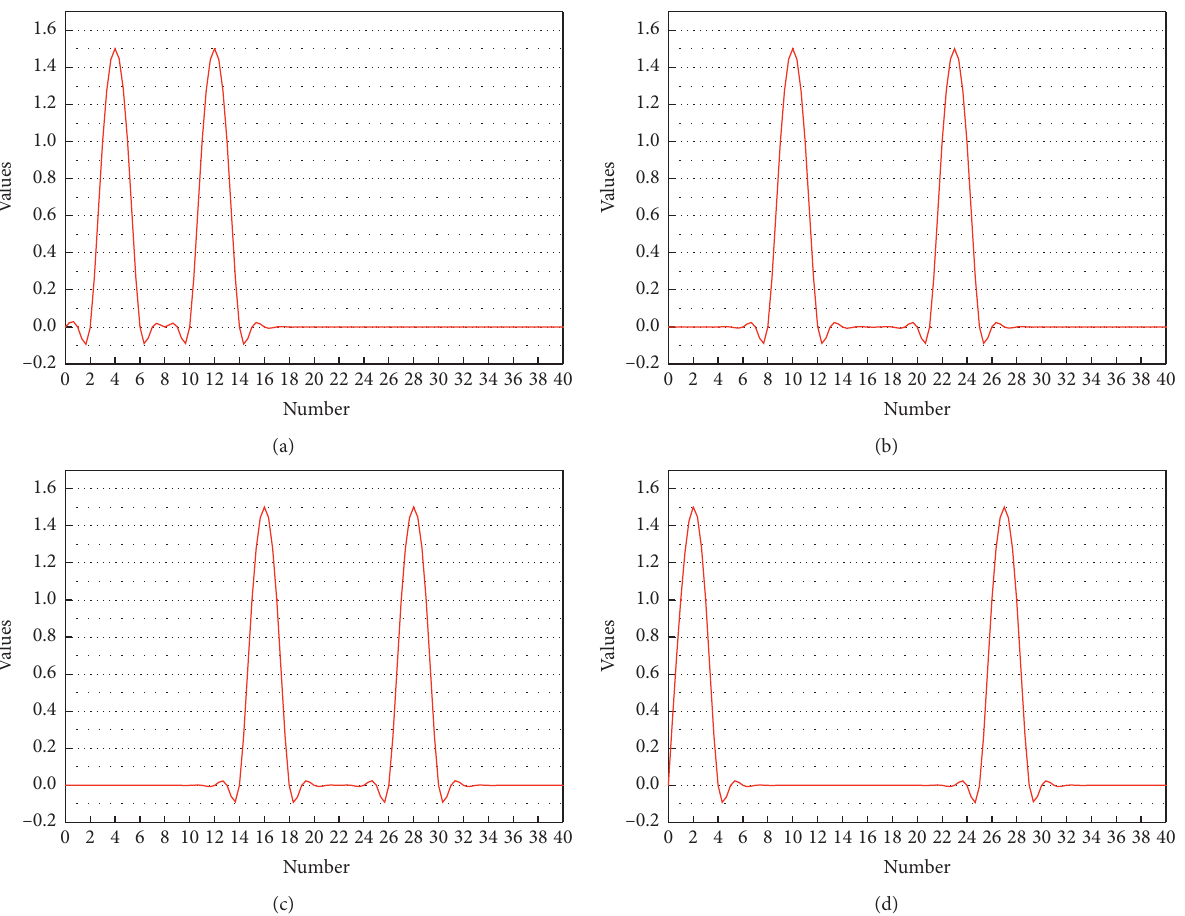
Figure 5: Simulation of each round refresh time of software platform transportation order library information.